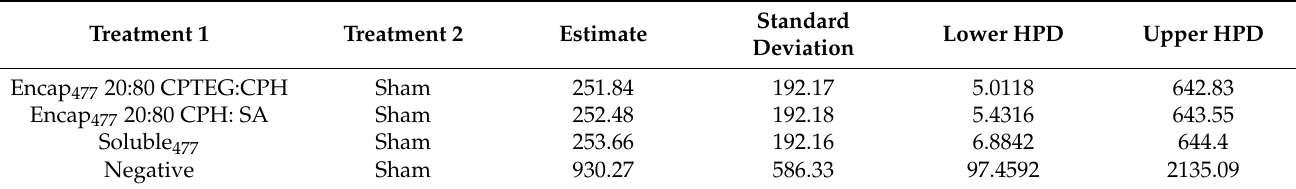
Table 4. The pairwise treatment differences from Bayesian analysis.